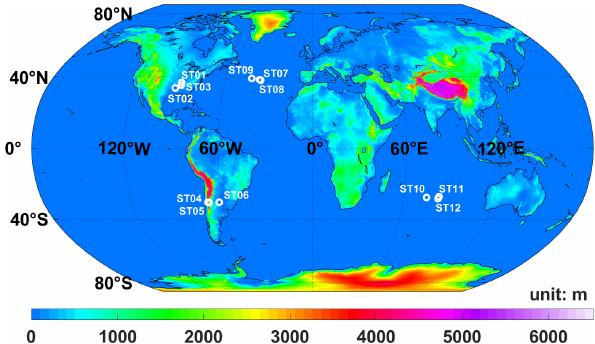
Figure 1. The 10arcmin global land topography. White circles are the locations of 12 sites, and the color bar represents global surface fluctuations. Topography data were abstracted from the ETOPO1 Ice Surface grid model (Amante and Eakins,